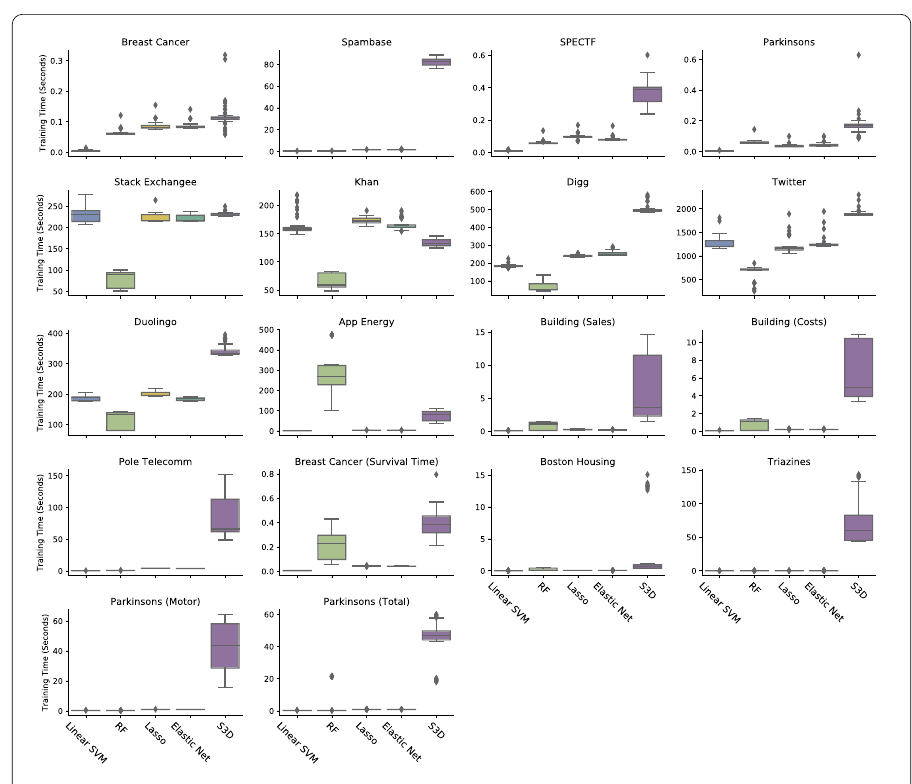
Figure 6 Boxplots of training time (seconds) of all five